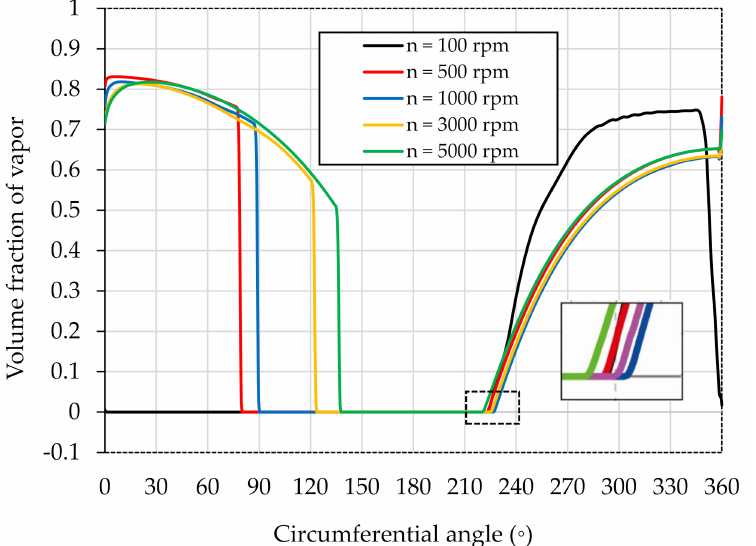
Figure 15. Profile of vapor volume fraction of the heterogeneous slip/no-slip bearing for different rotational velocity n . All results are evaluated at z / L =